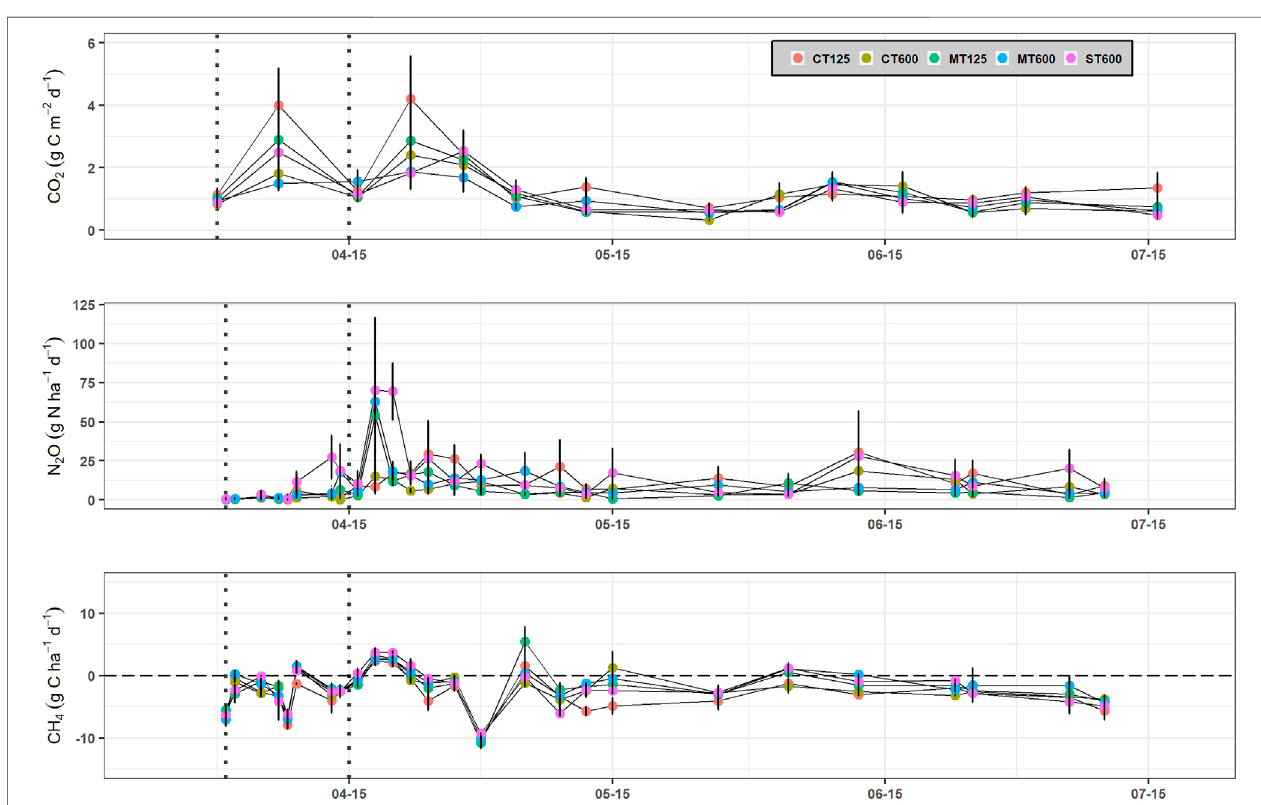
FIGURE4| SoilCO 2 ,N 2 OandCH 4 emissionsforeachcropestablishmentsysteminExp.1:conventionaltillageat125(CT125)and600 mm(CT600)rowspacing, minimum tillage at 125 (MT125) and 600 mm (MT600) row spacing, and strip tillage at 600 mm row spacing (ST600). Vertical dashed lines indicate fertilizer application and vertical lines on each data point represent the standard error of the